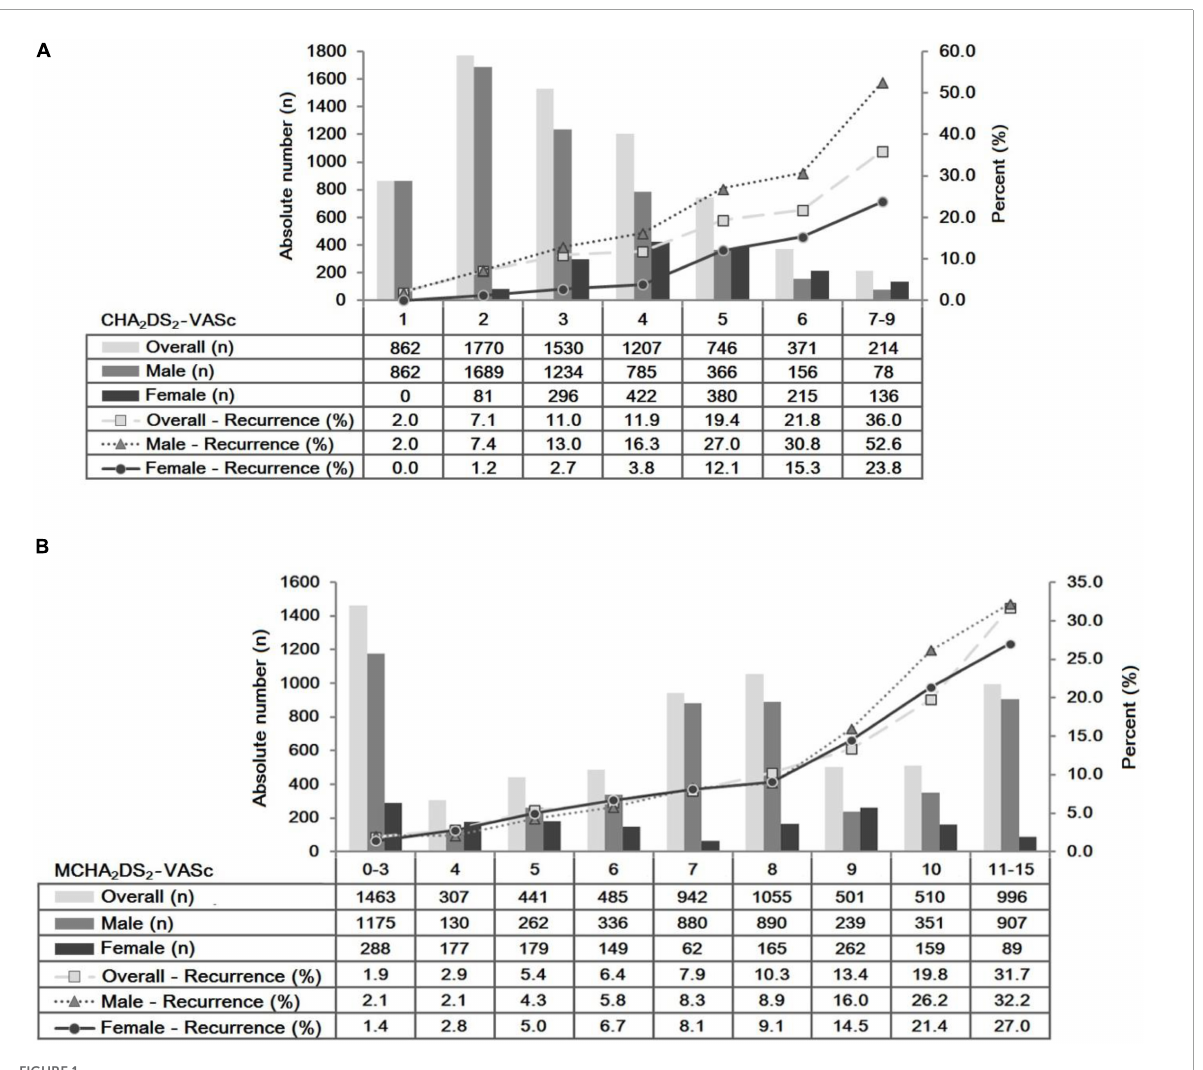
FIGURE1 Frequency distribution and incidence of recurrent myocardial infarction for congestive heart failure, hypertension, age 65–74 years, diabetes mellitus, vascular disease, female sex, age ≥ 75 years, and prior stroke/transient ischemic attack/embolus [CHA 2 DS 2 -VASc (A) ] and age ≥ 75 years, diabetes mellitus, dyslipidemia, prior stroke/transient ischemic attack/embolus, hypertension, male sex, and congestive heart failure [MCHA 2 DS 2 -VASc (B) ] scores’ strata, presented overall, male sex, and female